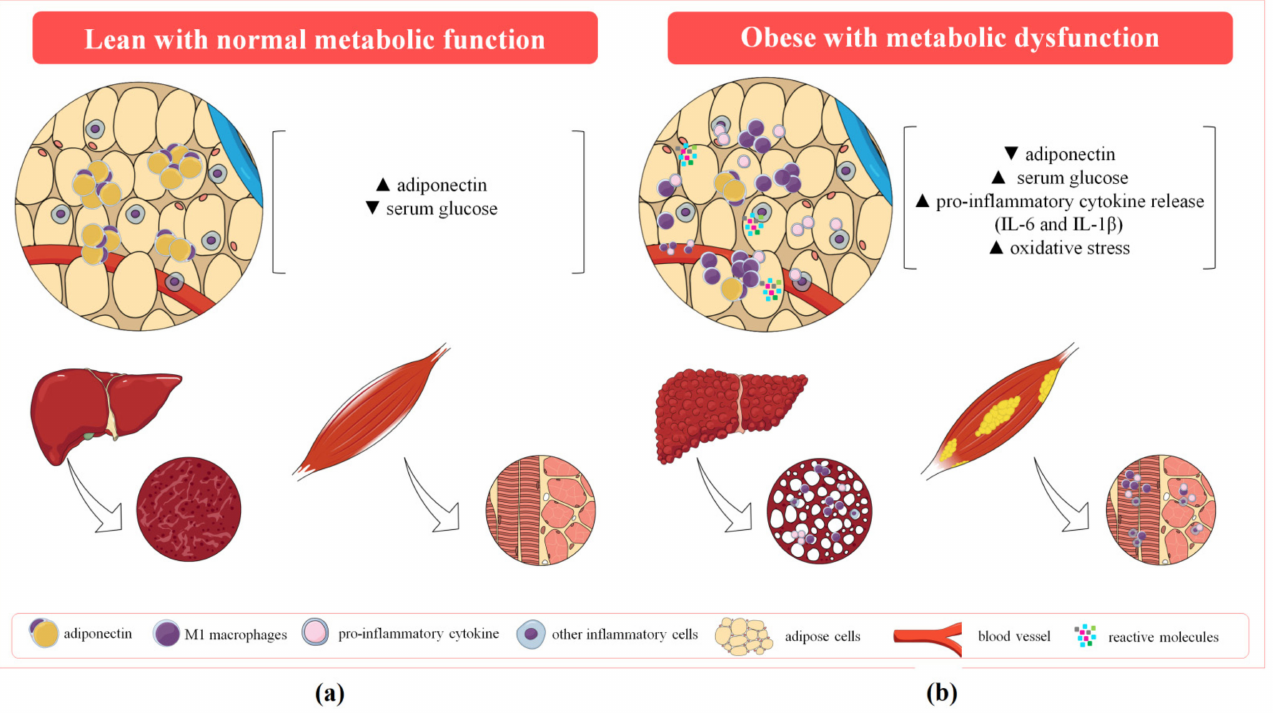
Figure 2. Fat tissue inflammation and adiponectin dysregulation in metabolic syndrome. ( a ) In lean individuals, adipose tissue contains few M2 macrophages and adipocytes produce high levels of adiponectin. Their insulin levels and sensitivity are regulated and result in normal glucose levels. ( b ) Individuals with metabolic dysfunction present with inflamed metabolic tissues with fat deposition and ROS production, which result in reduced cell viability and insulin resistance/high glucose